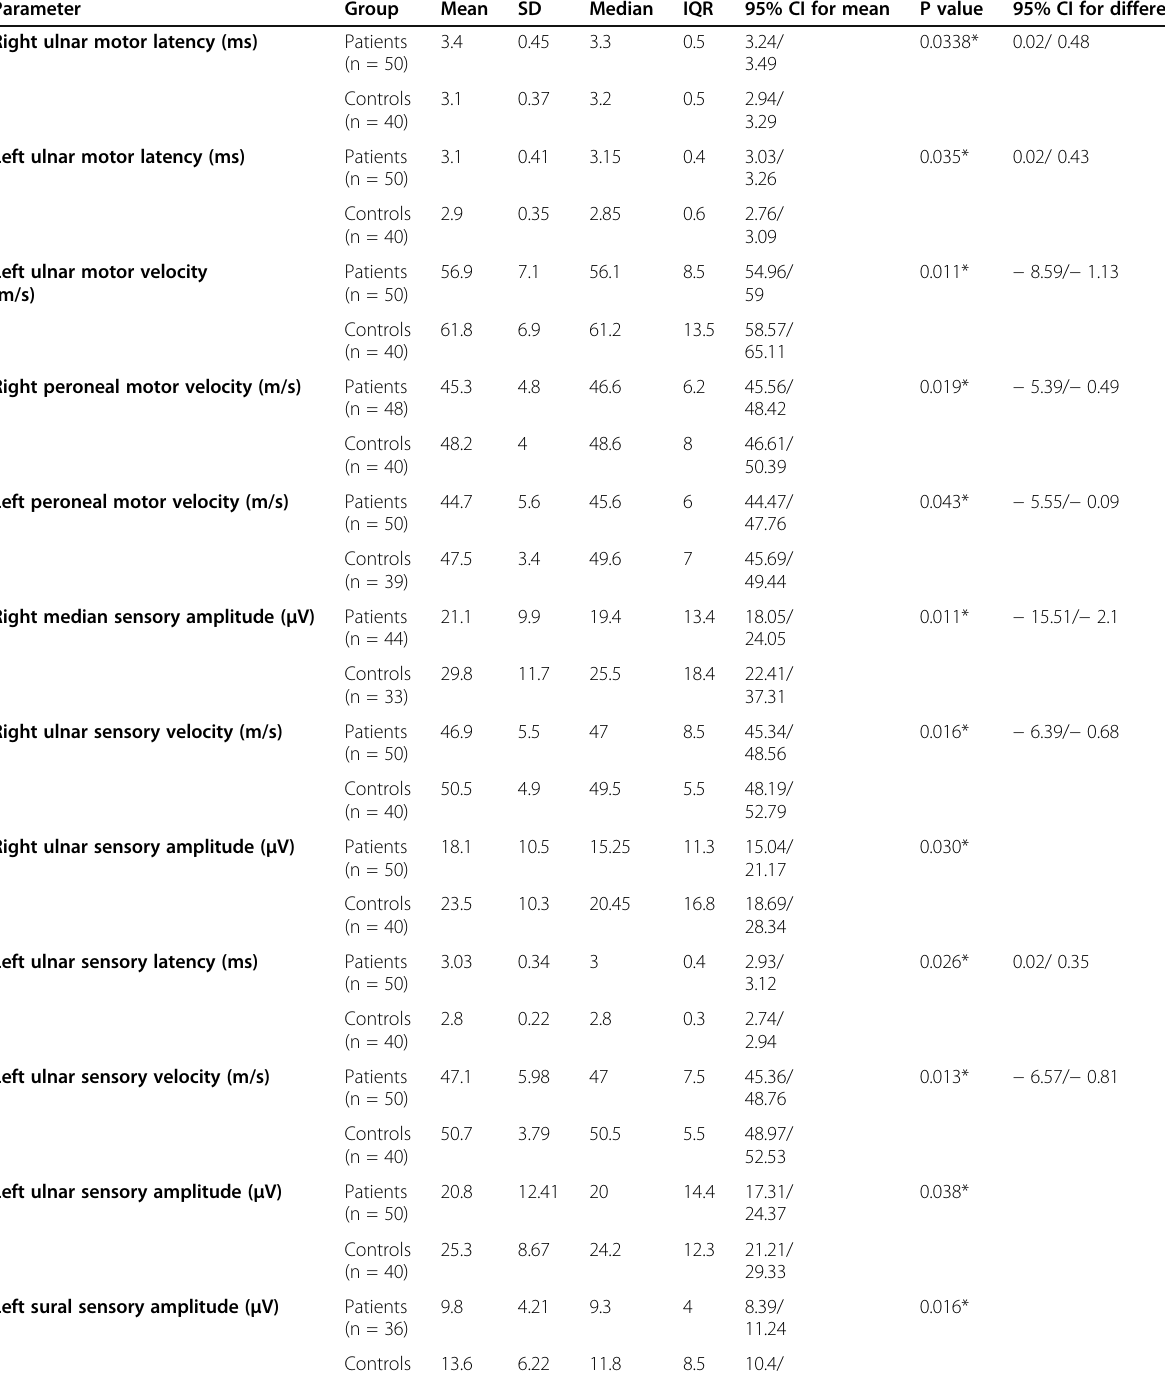
Table 3 Significant differences of nerve conduction findings between the two groups Parameter Group Right ulnar motor latency